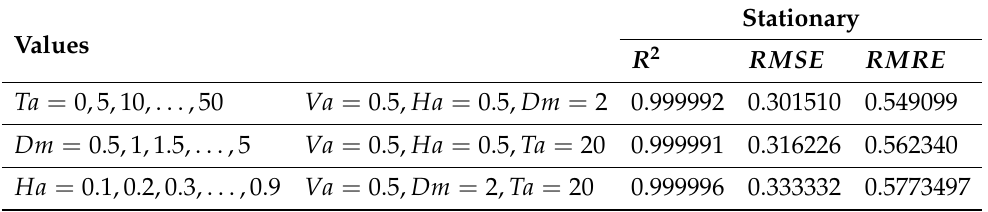
Table 2. Calculated oscillatory values of R 2 , RMSE , and RMRE at various values of Ta , Dm , and Ha . Oscillatory Values R 2 RMSE RMRE Ta = 0, 5, 10, . . . , 50 Va = 0.5, Ha = 0.5, Dm = 2 0.999999 0.447213 0.668740 Dm = 0.5, 1, 1.5, . . . , 5 Va = 0.5, Ha = 0.5, Ta = 20 0.999994 0.316226 0.562340 Ha = 0.1, 0.2, 0.3, . . . , 0.9 Va = 0.5, Dm = 2, Ta = 20 0.999966 0.333327